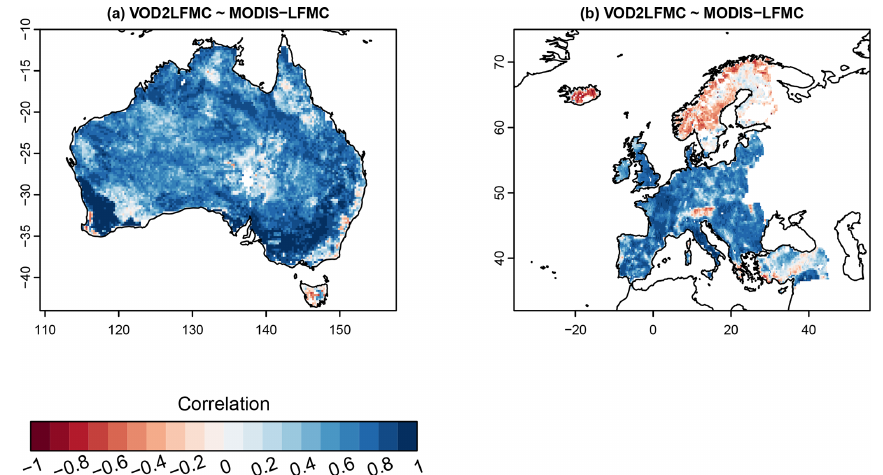
Figure A3. Pearson correlation between the VOD-based LFMC from Model B and MODIS-LFMC for Australia and Europe for the time period February 2000 to July